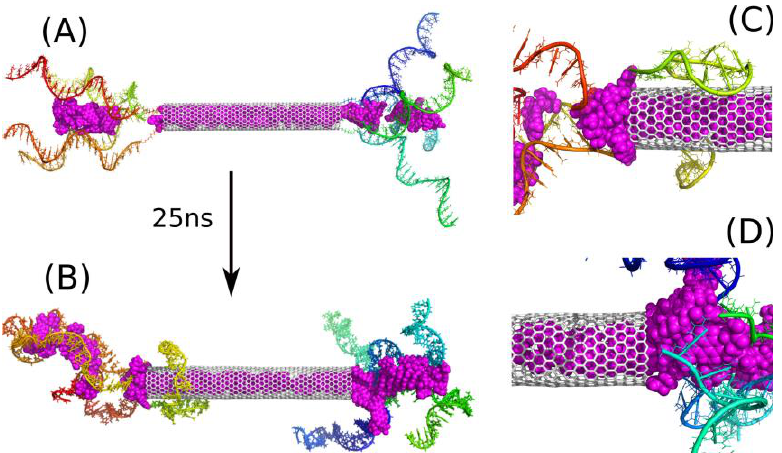
Figure 3. ( A ) Initial state of E4D40 system, i.e., with additional 20 DOX (magenta) molecules placed initially in the space between iM chains; ( B ) the state of E4D40 system after 25 ns of simulations. ( C ) and ( D ) show zoomed-in areas around CNT tips. The rainbow colors of iM chains are for illustration purposes